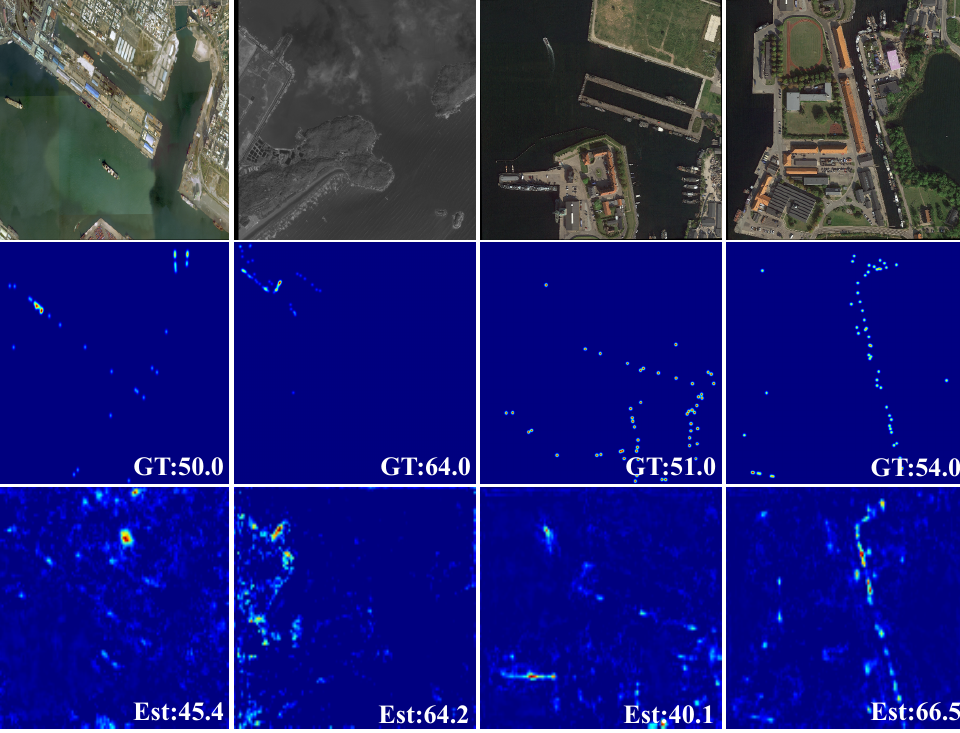
Figure 8. Subjective results on the RSOC_ship